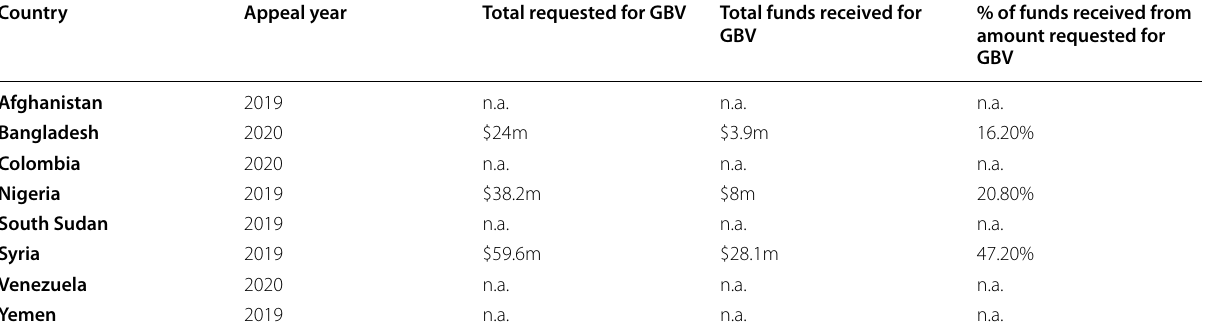
Source(s): (FTS 2019d, c, b, a, 2020d, c, b,